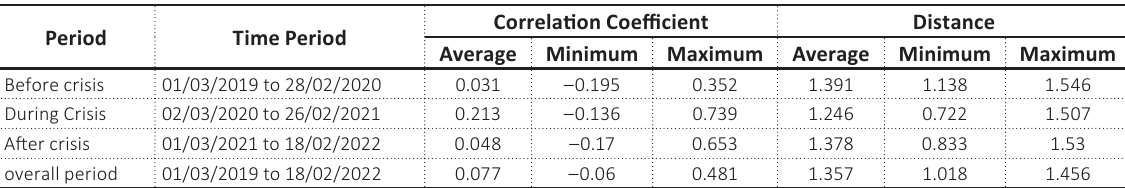
Table 1. Summary observations before, during, and after the first year of the COVID-19 pandemic in Morocco and the overall